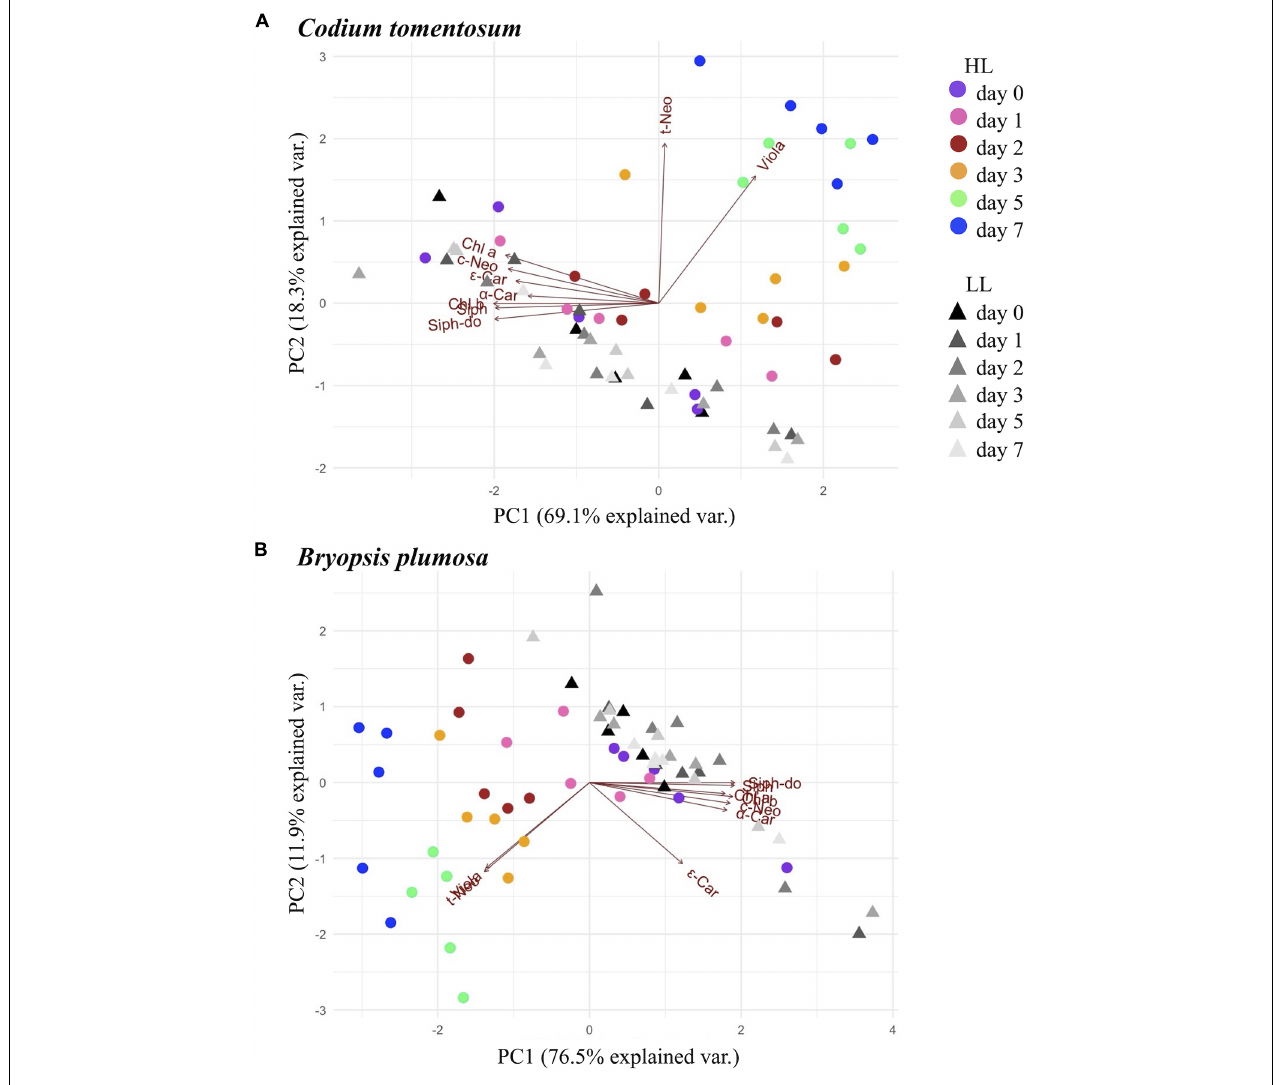
FIGURE 2 | Principal component analysis (PCA) analysis of pigments ( µ mol g − 1 dw) in Bryopsidales macroalgae during 7 days of low and high light acclimation. (A) Codium tomentosum ; (B) Bryopsis plumosa .